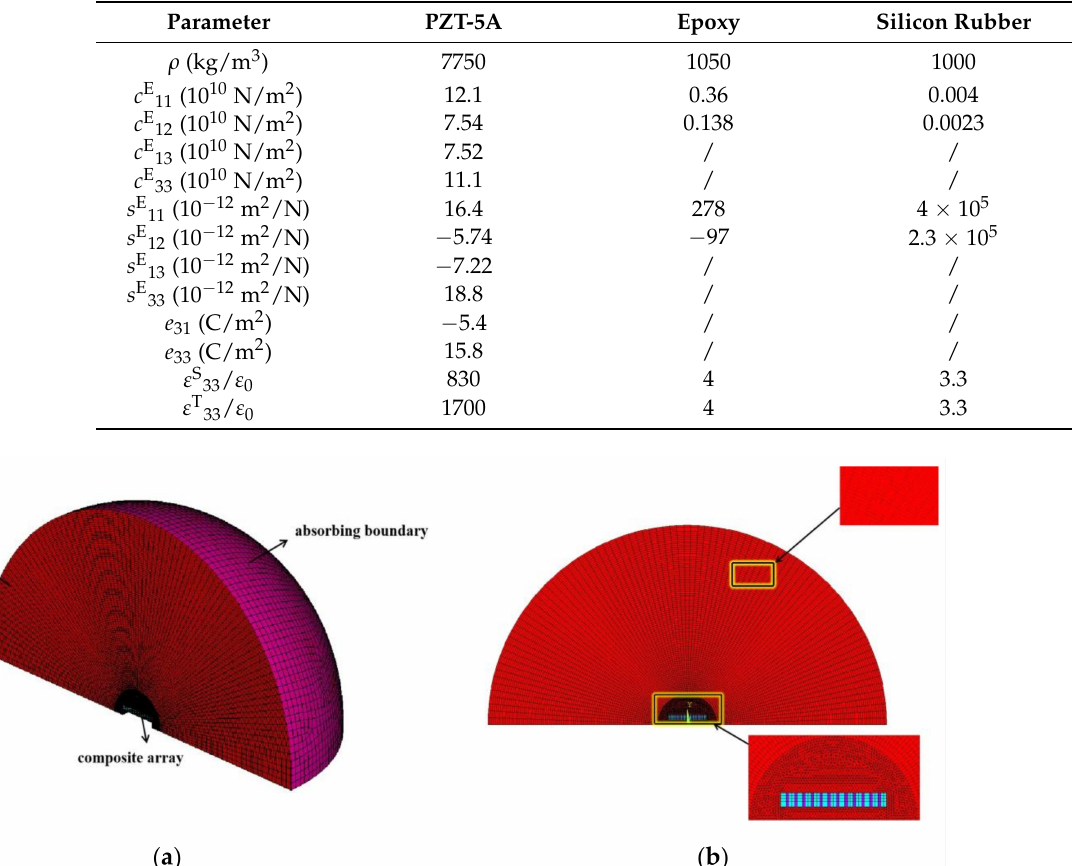
Figure 3. Water field simulation modeling in ANSYS. ( a ) A three-dimensional diagram of the water field; ( b ) Local structure diagram of the water